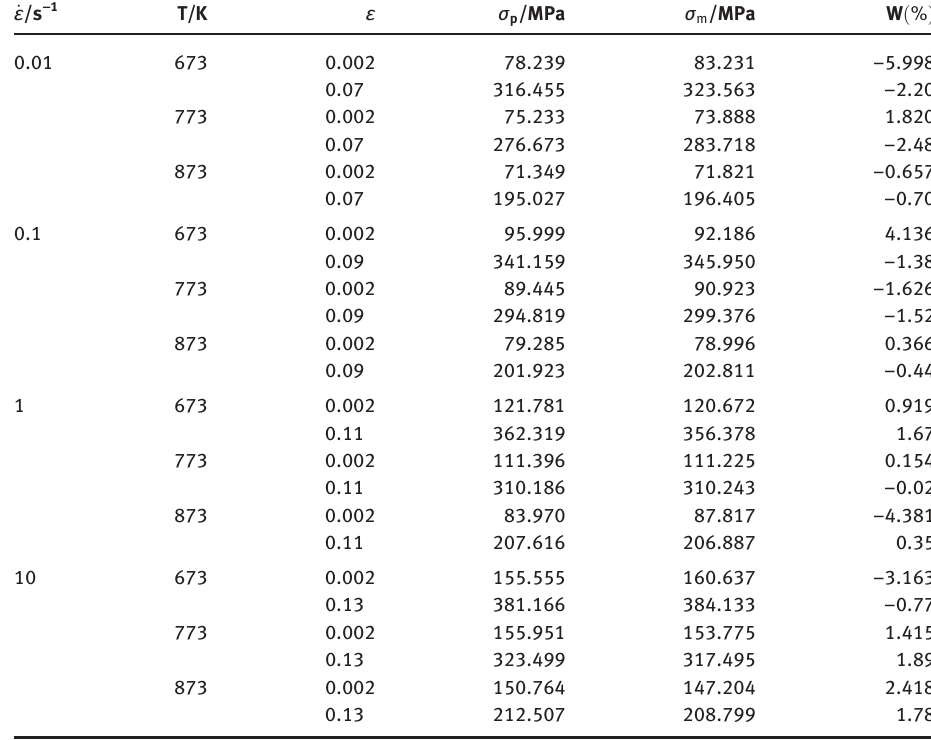
Table 9: Comparisons of the predicted results and experimental results under medium temperatures with different strain rates at specific